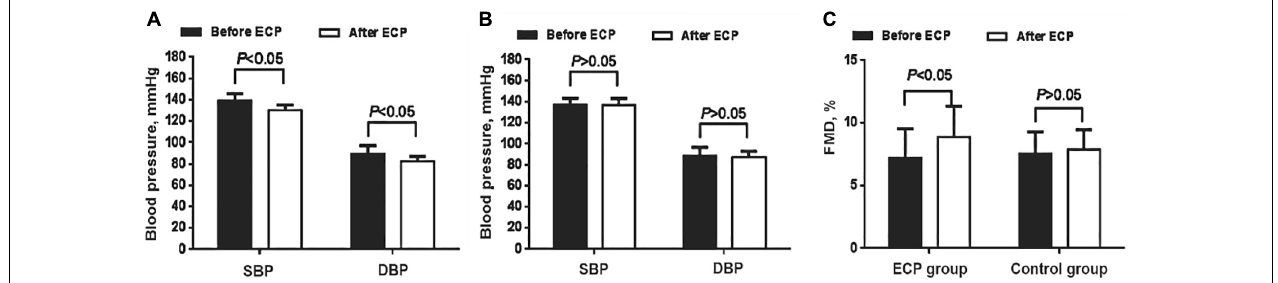
FIGURE 1 | Comparison of blood pressure and FMD change in both groups. (A) Both SBP and DBP decreased after EECP in the interventional group ( P < 0.05). (B) Neither SBP nor DBP decreased in the control group. (C) FMD increased after EECP in the interventional group ( P < 0.05); no similar pattern was found in the